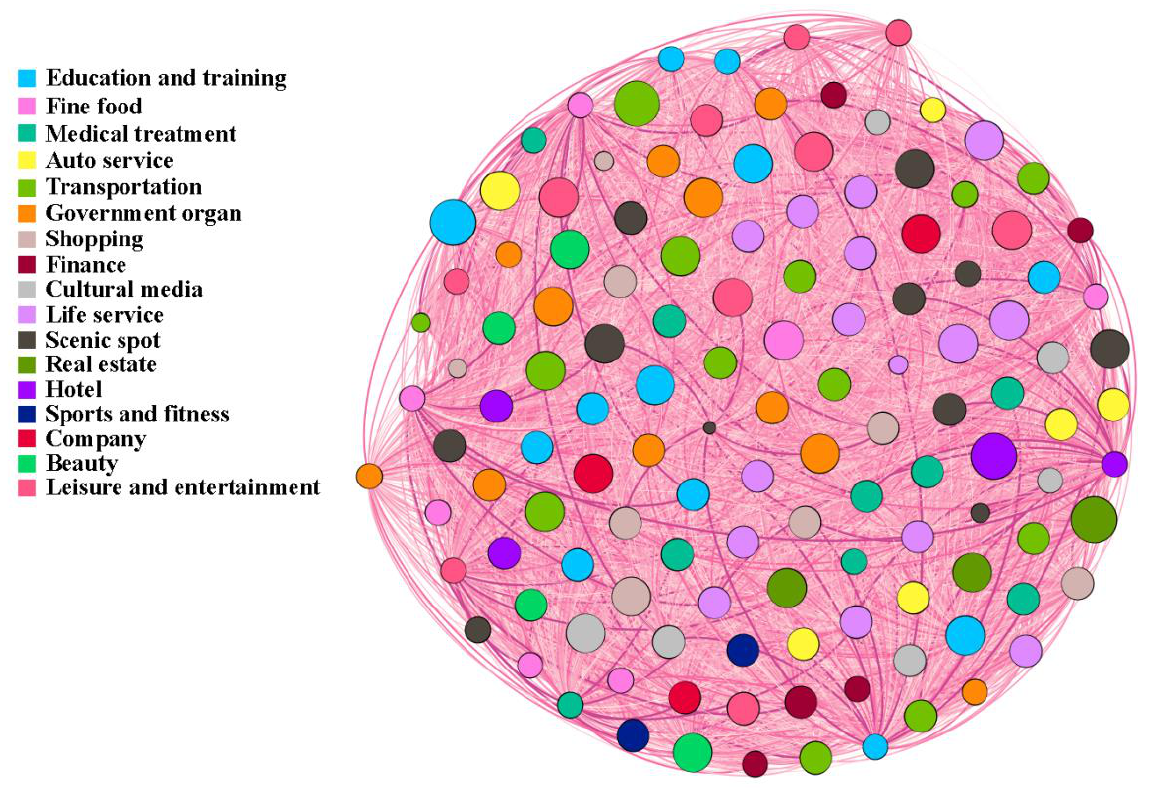
Figure 5. Complex network of urban functions before the lockdown of COVID-19 in Shenzhen.